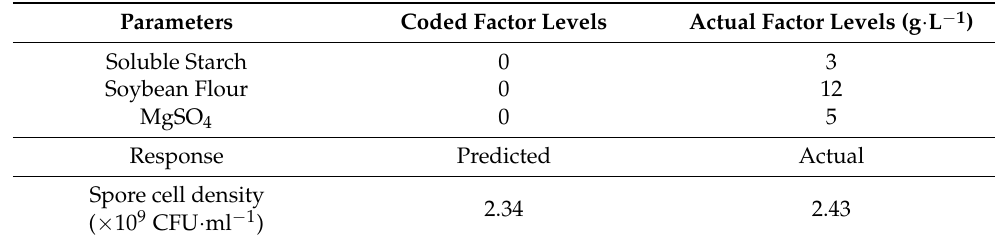
Table 4. Numerical optimization and validation of pretreatment based on the regression